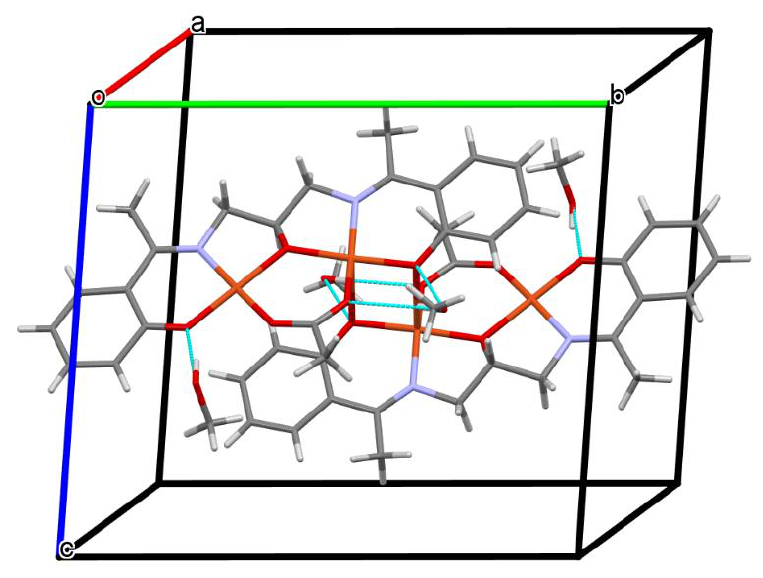
Figure 8. A view of O–H ··· O hydrogen bonds in a tetranuclear unit of 3.